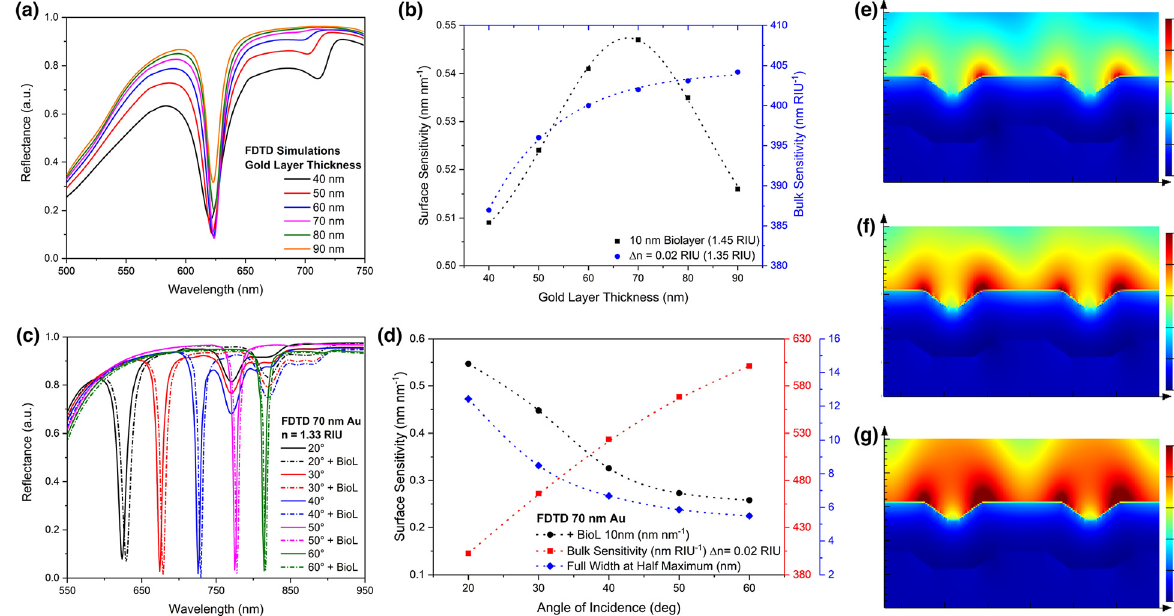
Figure 2: FDTD simulations of the proposed 1D plasmonic nanocrystals for optimized plasmonic biosensing. (a) FDTD simulated reflectance under TM-polarization with a fixed light incident angle of 20 ° for different Au layer thicknesses. (b) In fl uence of thedifferentAuthicknessinthesensingandbiosensingperformanceoftheplasmonicnanostructures.(c)FDTDsimulatedre fl